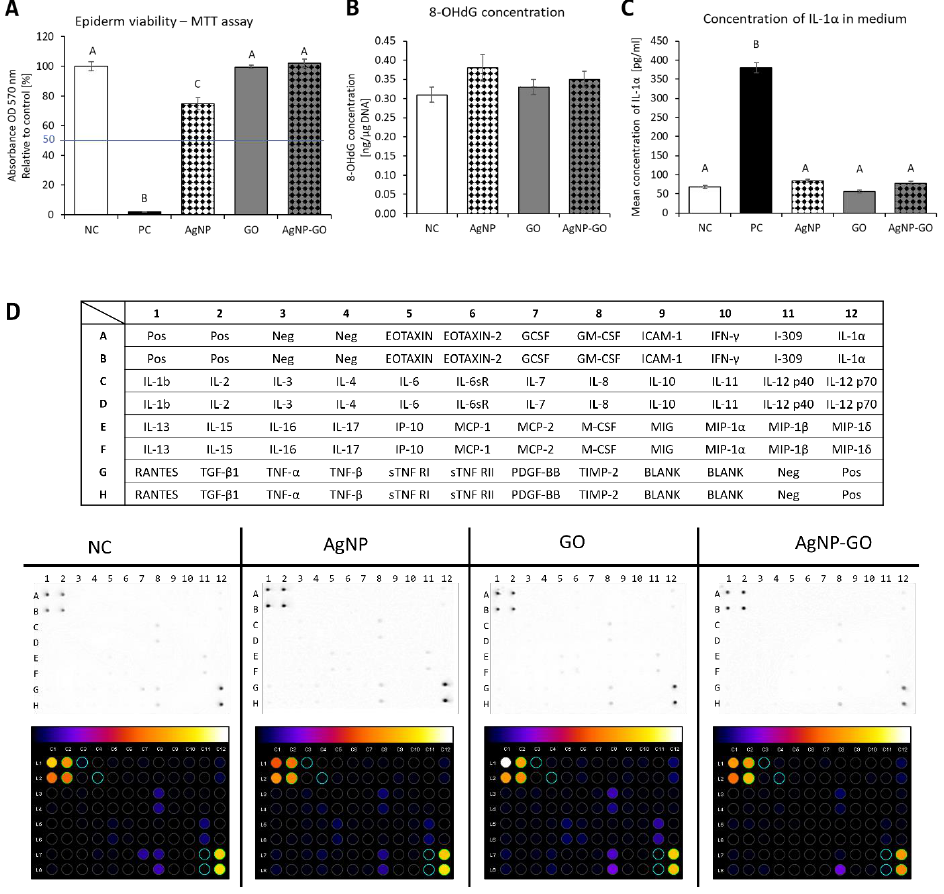
Figure 3. Biocompatibility of nanomaterials with Epiderm™. NC— negative control (DPBS), PC — positive control (5% SDS), AgNP — silver nanoparticles, GO — graphene oxide, AgNP-GO — com- positive control (5% SDS), AgNP—silver nanoparticles, GO—graphene oxide, plex. ( A ) EpiDerm™ viability measured by mitochondrial activity depletion. The MTT assay was performed 48 h after nanofactor treatments. The blue line represents the critical point at the level of